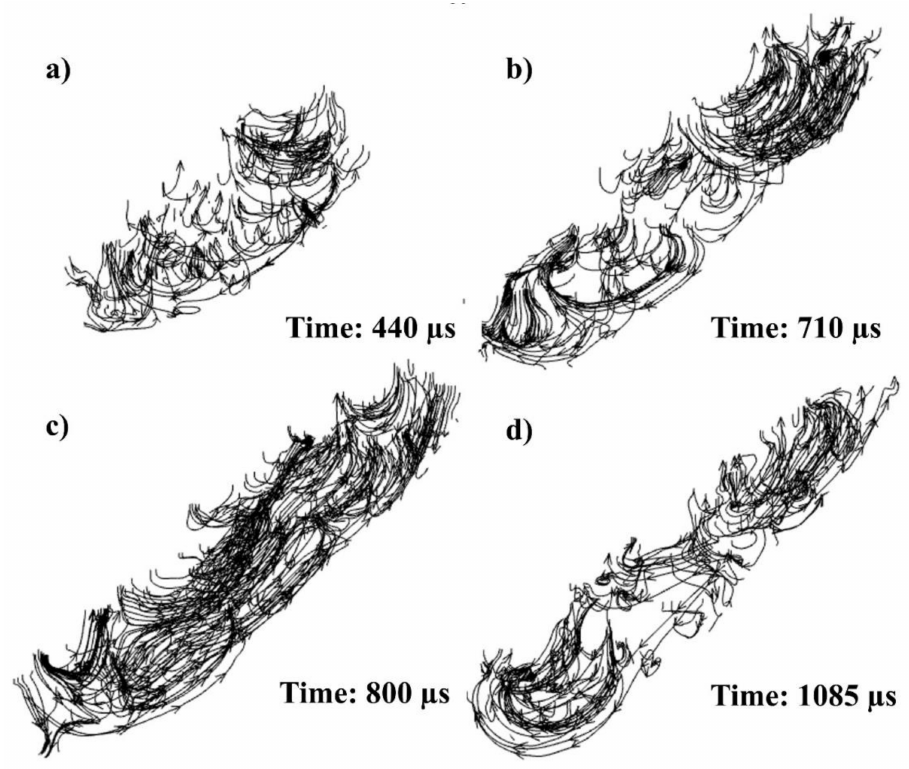
Figure 11. Stream traces of single track in 3D at ( a ) 440, ( b ) 710, ( c ) 800, and ( d ) 1085 µ